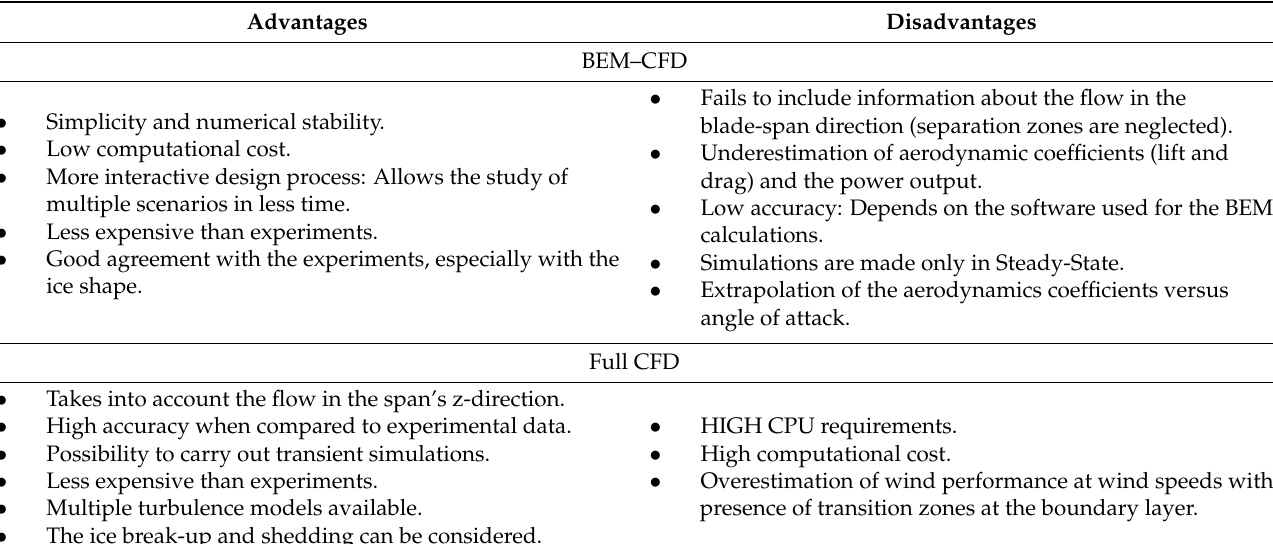
Table 2. Summary of advantages and disadvantages of BEM–CFD and Full CFD